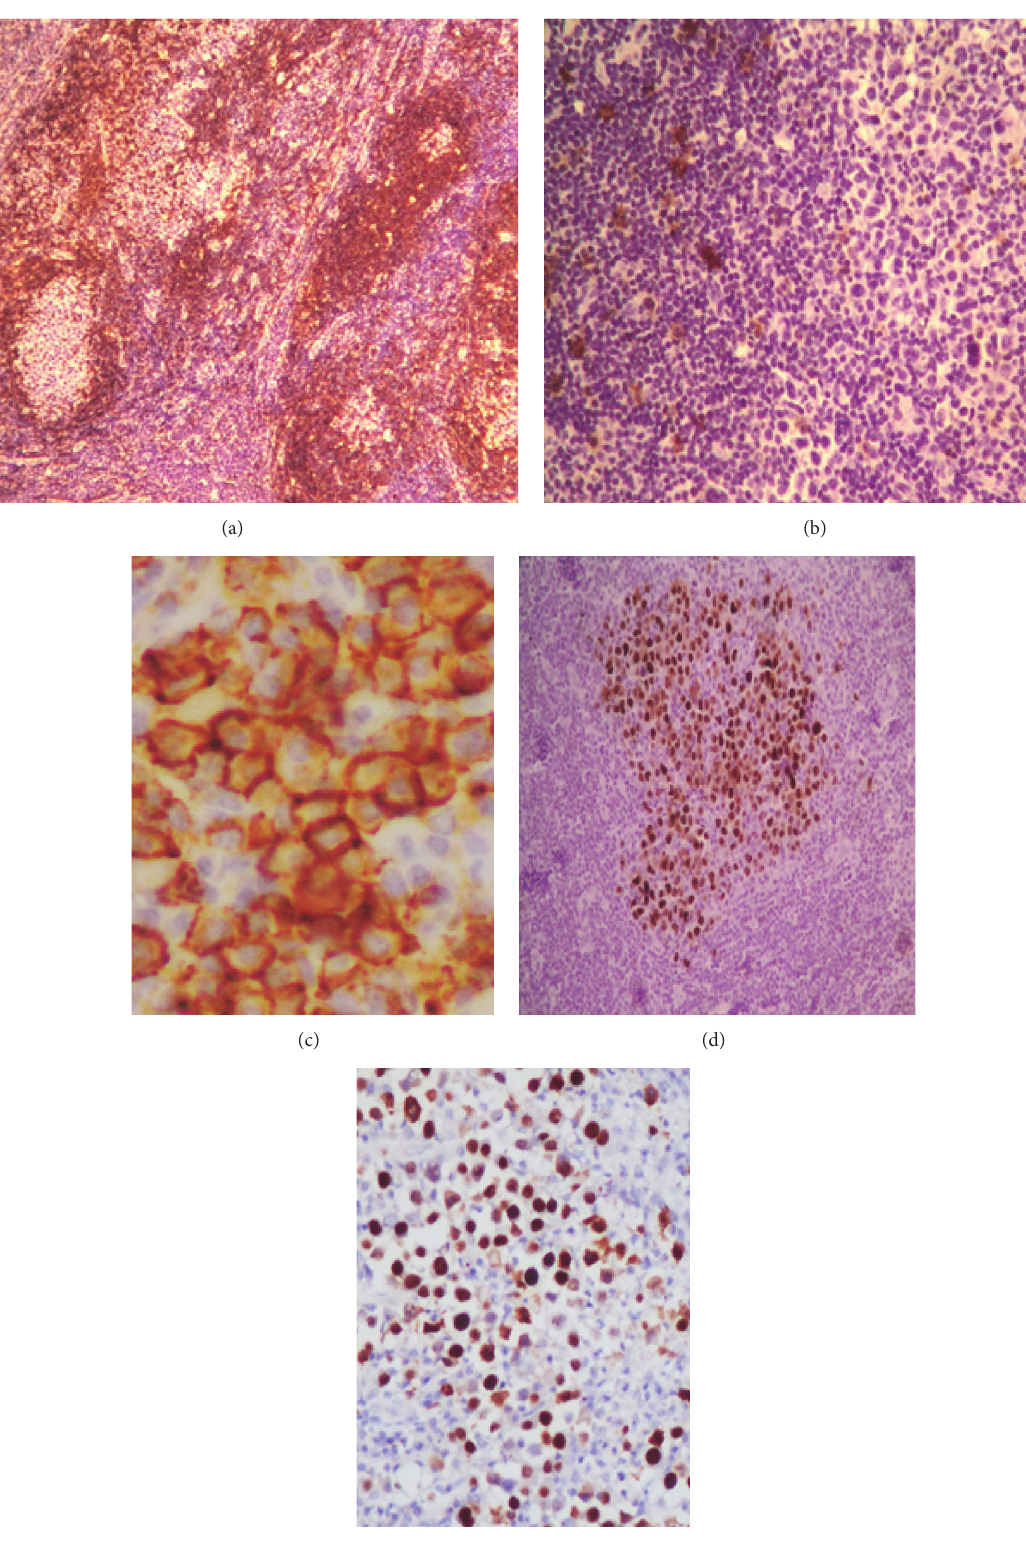
Figure 3: HHV8/EBV-associated germinotropic lymphoproliferative disorder: large lymphoid cells showed negative immunostaining for CD20 (magnification × 25) (a) and CD30 (magnification × 100) (b). Intense immunostaining for CD38 (magnification × 200) (c) and HHV8 (magnification × 100) (d); EBER in situ hybridization positivity of many tumor cells (magnification × 200)